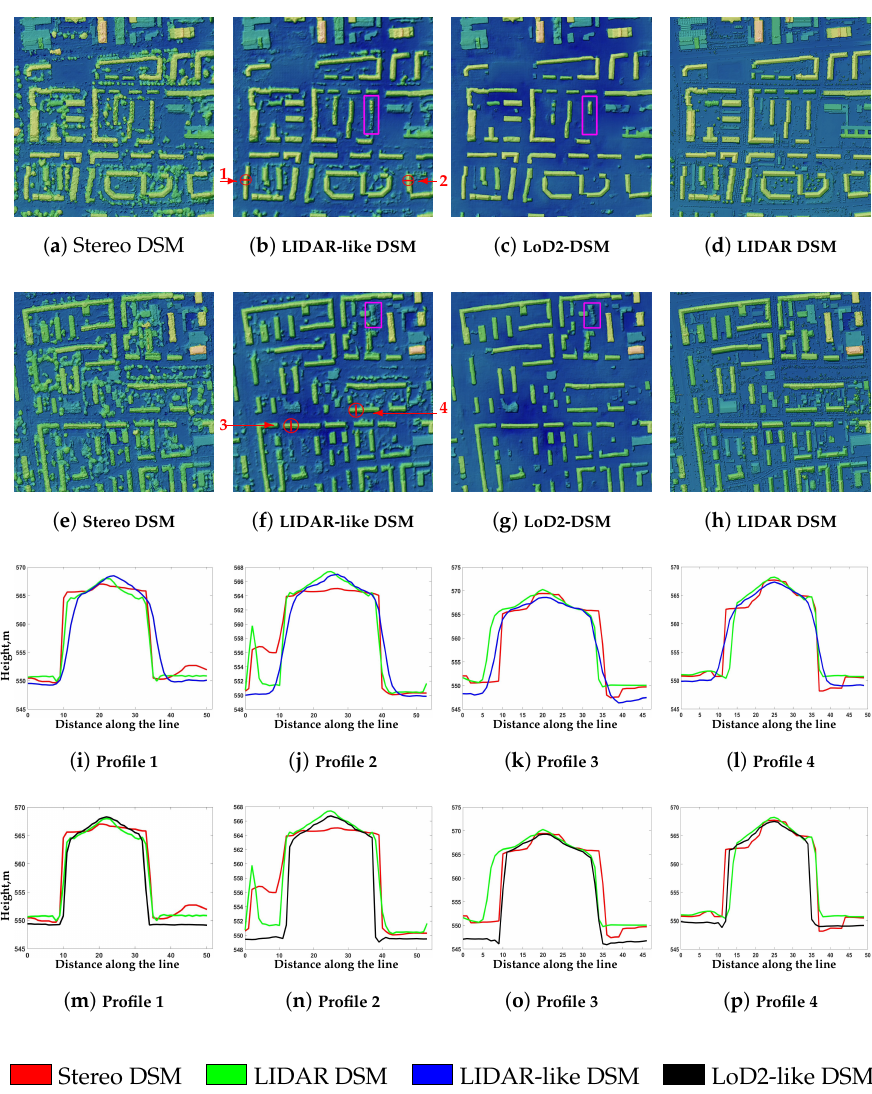
Figure 9. Visual analysis of generalization by cLSGAN architecture over selected urban areas of Munich city using both setups LoD2-DSM and LIDAR-DSM. The DSM images are color-shaded for better visualization. ( a , e ) depict the input stereo DSM data, ( b , f ) is the generated DSM from LIDAR-DSM, ( c , g ) is the generated DSM from LoD2-DSM, and ( d , h ) is the LIDAR ground truth data. The profiles of selected buildings from DSM generated by LIDAR-DSM setup are illustrated in the third line, and the ones from LoD2-DSM setup are in the fourth line.